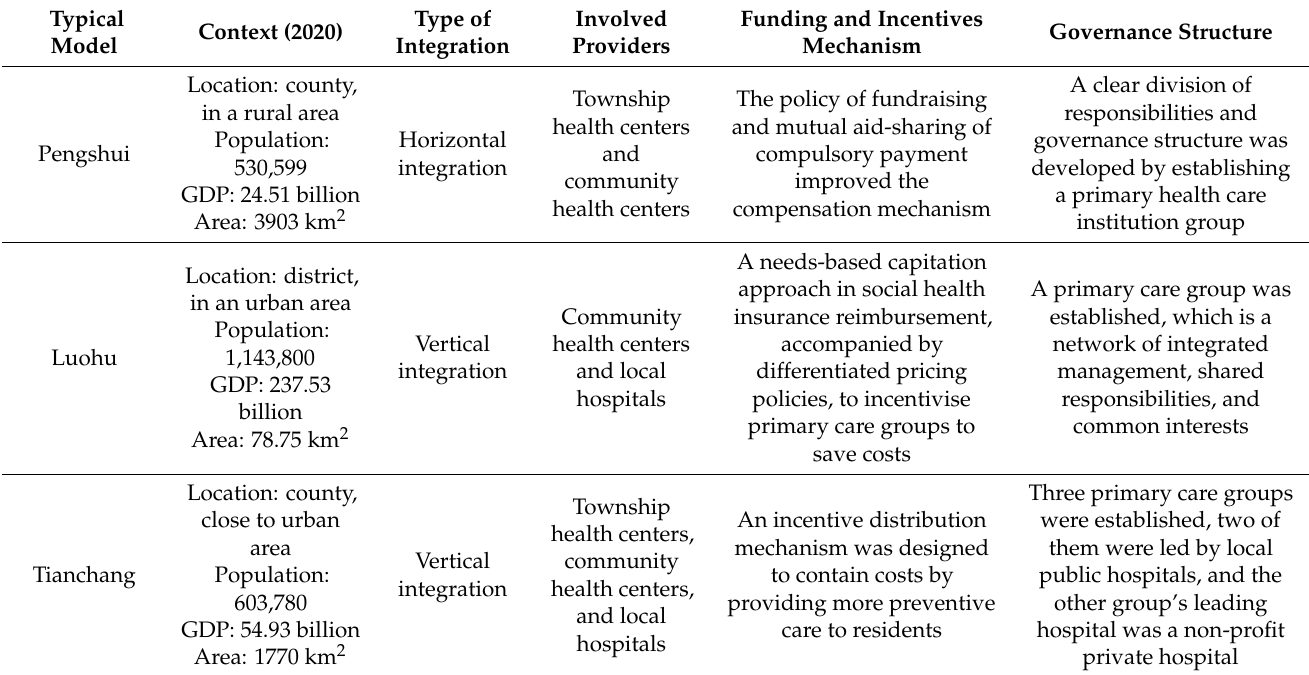
Table 2. Comparison of typical integrated care models in primary care in